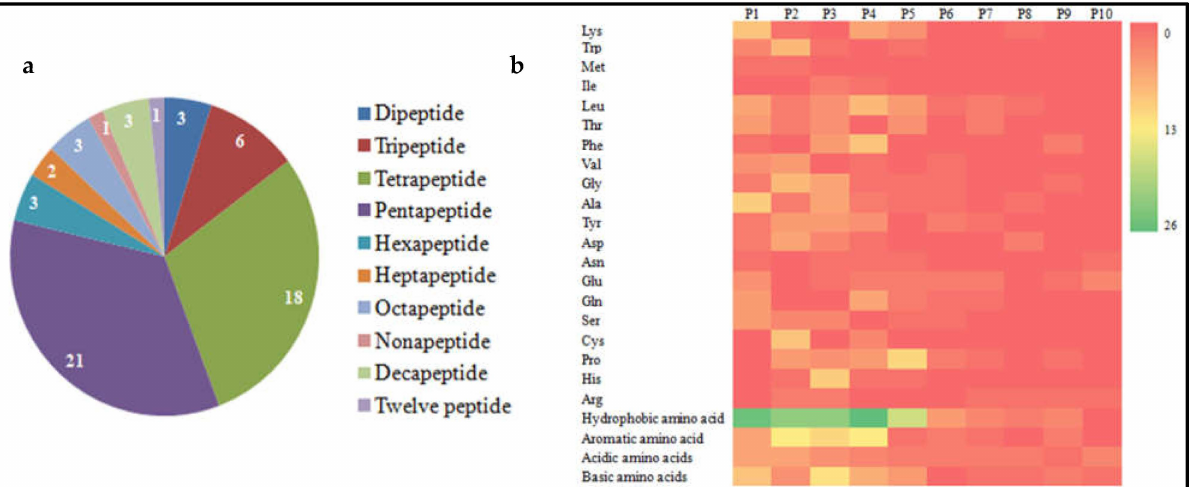
Figure 3. Characterization of antioxidant peptides from nut proteins. ( a ) The pie chart shows the proportions of the identified antioxidant peptides. The numbers on the pie chart indicate the number of each type of peptide. ( b ) Heat map of the frequency of amino acid residues occurring at the residues located from the first position (P1) to the tenth position (P10) of the N-terminus amino acid of the identified antioxidant